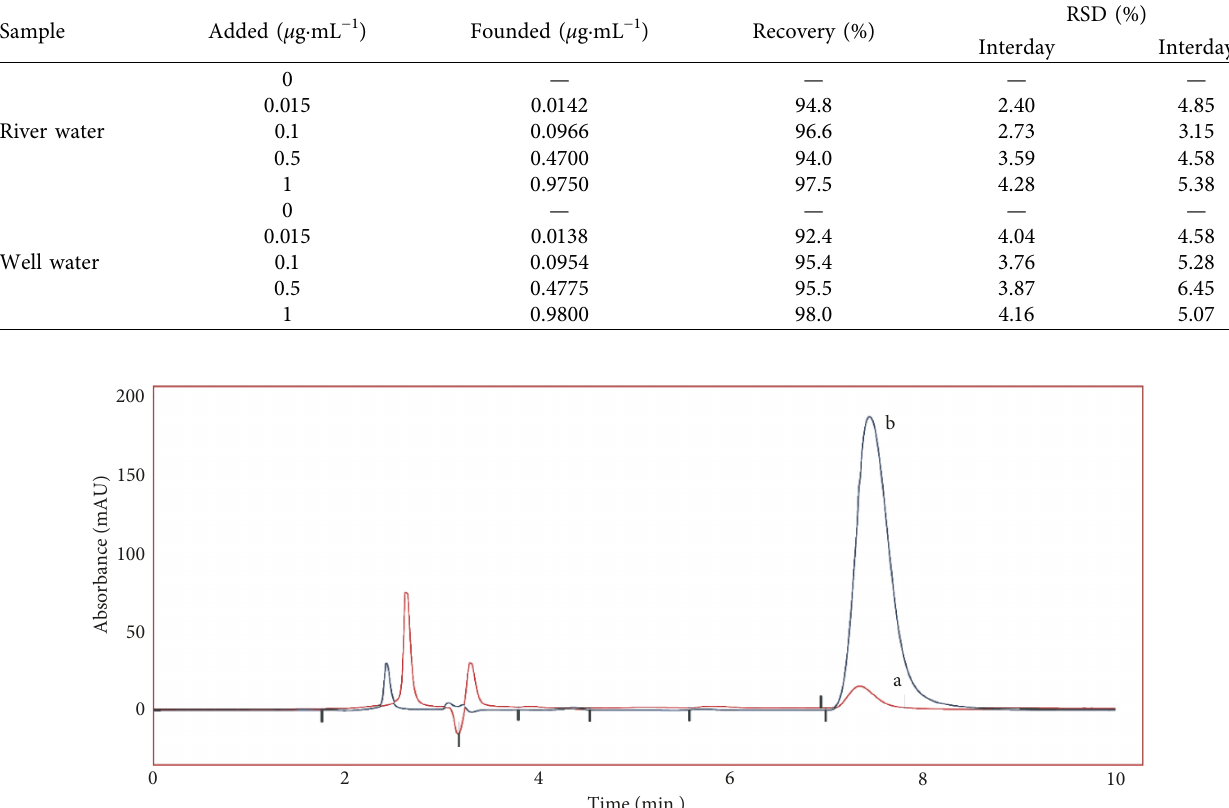
Figure 5: Typical chromatograms of (a) direct injection of spiked well water sample and (b) spiked well water sample after SPME-MIP procedure. Spiked concentration: 0.1 μ g · mL − 1 . Table 3: Comparison with reported methods for the determination of phenobarbital Extraction